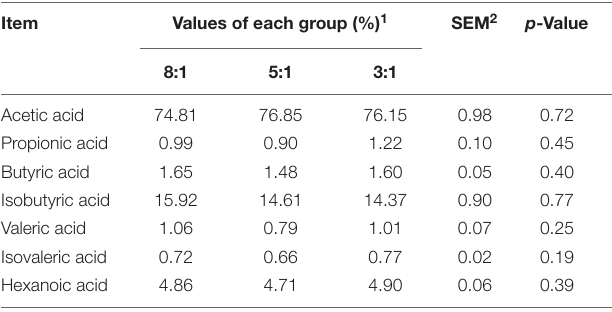
TABLE 2 | Short chain fatty acid composition in serum of Heigai pigs fed with different diets. Item